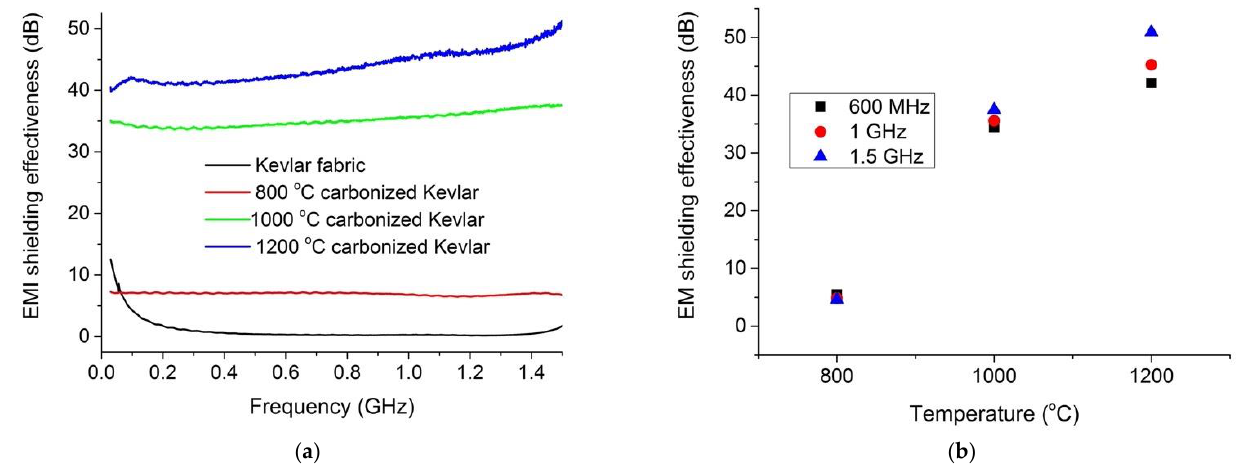
Figure 10. Electromagnetic shielding effectiveness in low frequency region; ( a ) effect of frequency; and ( b ) effect of carbonization temperature.